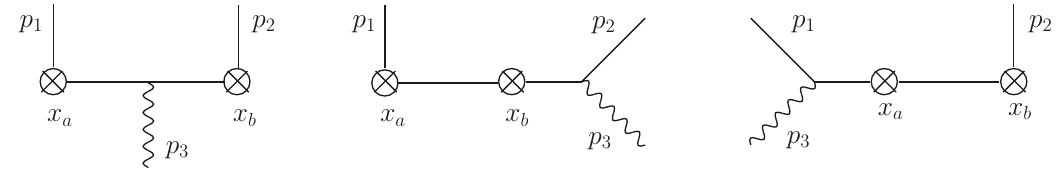
Figure 1 . Feynman diagrams contributing to the generalized form factor F ( x a ; x b j p 1 ; p 2 ; p 3 ), eq. (3.25), in the theory with the Lagrangian